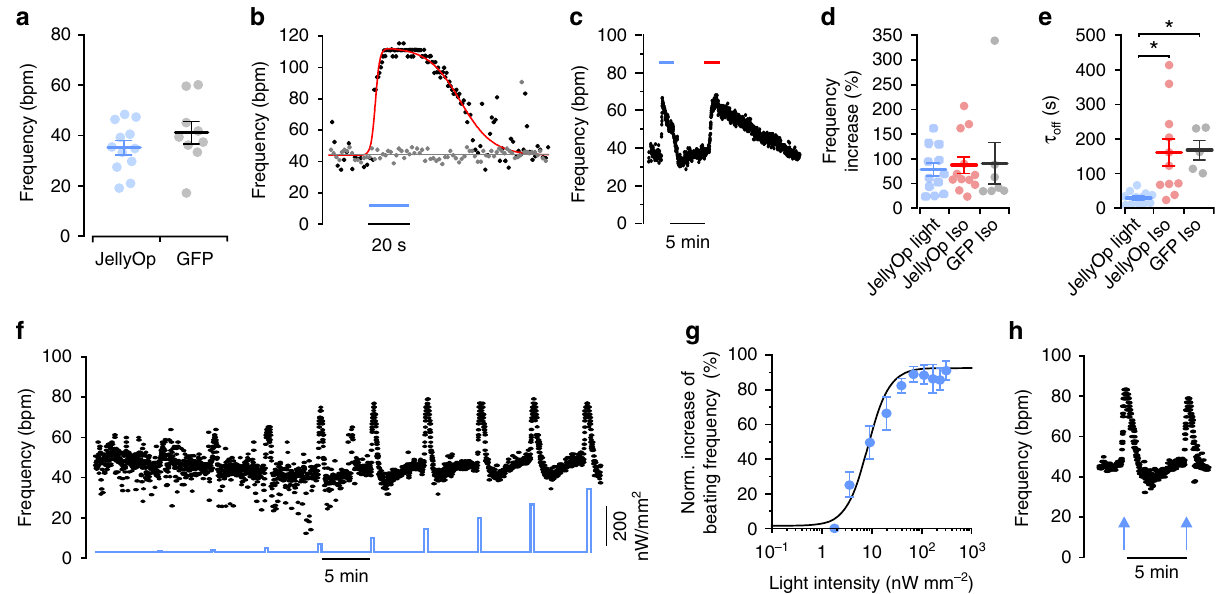
Fig. 2 JellyOp activates G s -signaling in ESC-derived cardiomyocytes. a Baseline frequencies of unstimulated spontaneously beating EBs expressing JellyOp ( n = 12) or GFP only ( n = 9) (two-sided unpaired Student's t -test: p = 0.2527). b Spontaneous beating frequency during illumination (blue bar, 309 nW mm − 2 ) of a JellyOp (black dots, fi t in red see Methods) and a GFP control EB (gray). c Representative frequency trace of a JellyOp EB during stimulation by light (blue bar, 309 nW mm − 2 ) or with isoprenaline (red bar, 1 µ M). d , e Statistical analysis of maximal beating rate increase ( d ) and deactivation time constant ( τ off ) after termination of stimulation ( e ) using JellyOp and GFP control EBs ( n = 5 – 12, one-way ANOVA: p = 0.924 ( d ), Welch ANOVA, p = 0.003 ( e ), Games – Howell post-test: * p < 0.05). f Representative frequency trace of a JellyOp EB during stimulation by light pulses (20 s, 5 min delay) with stepwise increasing light intensities (2 – 309 nW mm − 2 ). g Relationship between normalized peak frequency increase and light intensity fi tted with Hill equation ( n = 5). h Frequency trace upon illumination with two supramaximal light intensities (blue arrows: left 1770 and right 2370 nW mm − 2 , 20 s). Error bars: in JellyOp and GFP control EBs (Fig. 2c, d). In contrast, return to